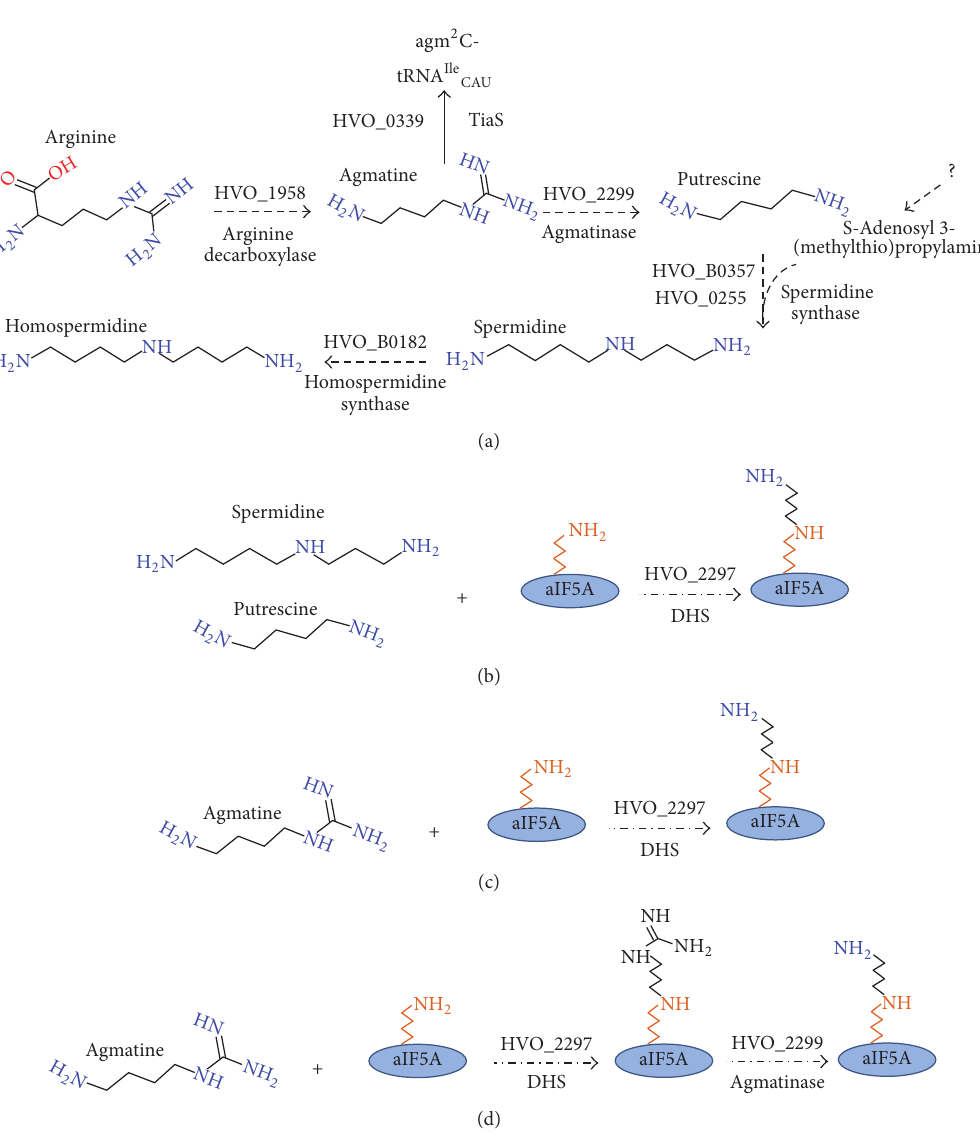
Figure 1: Proposed models of polyamines metabolism and aIF5A in Hfx. volcanii . (a) Predicted pathways of polyamines synthesis from arginine substrate. Dashed arrows indicate proposed reaction; solid arrow indicates known reaction. (b–d) Proposed substrates of DHS. HVO 1958 encodes a potential arginine decarboxylase; HVO 2299 an agmatinase-like; HVO 0255 a spermidine synthase; HVO B0182 a spermidine synthase or a homospermidine synthase; and HVO 2297 a potential deoxyhypusine